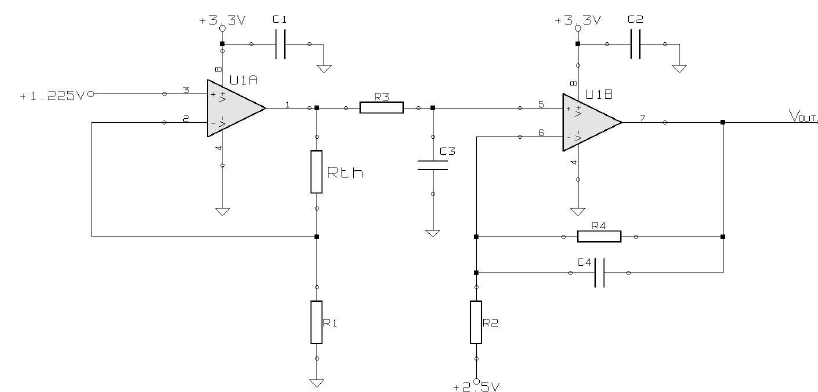
Schematic of the thermistor amplifier circuit. The first opamp circuit